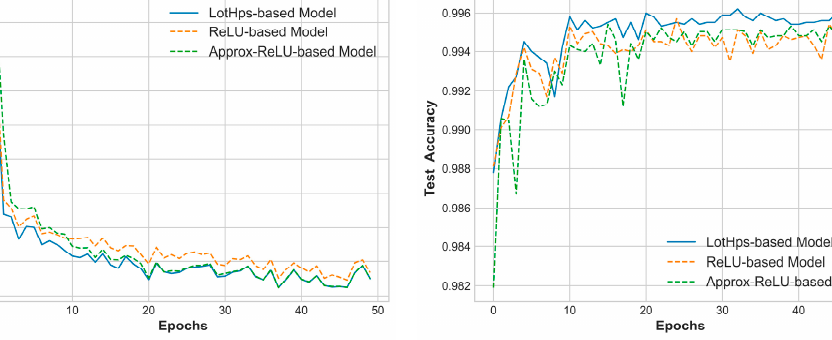
Figure 4. Comparison of train loss and test accuracy on MNIST.